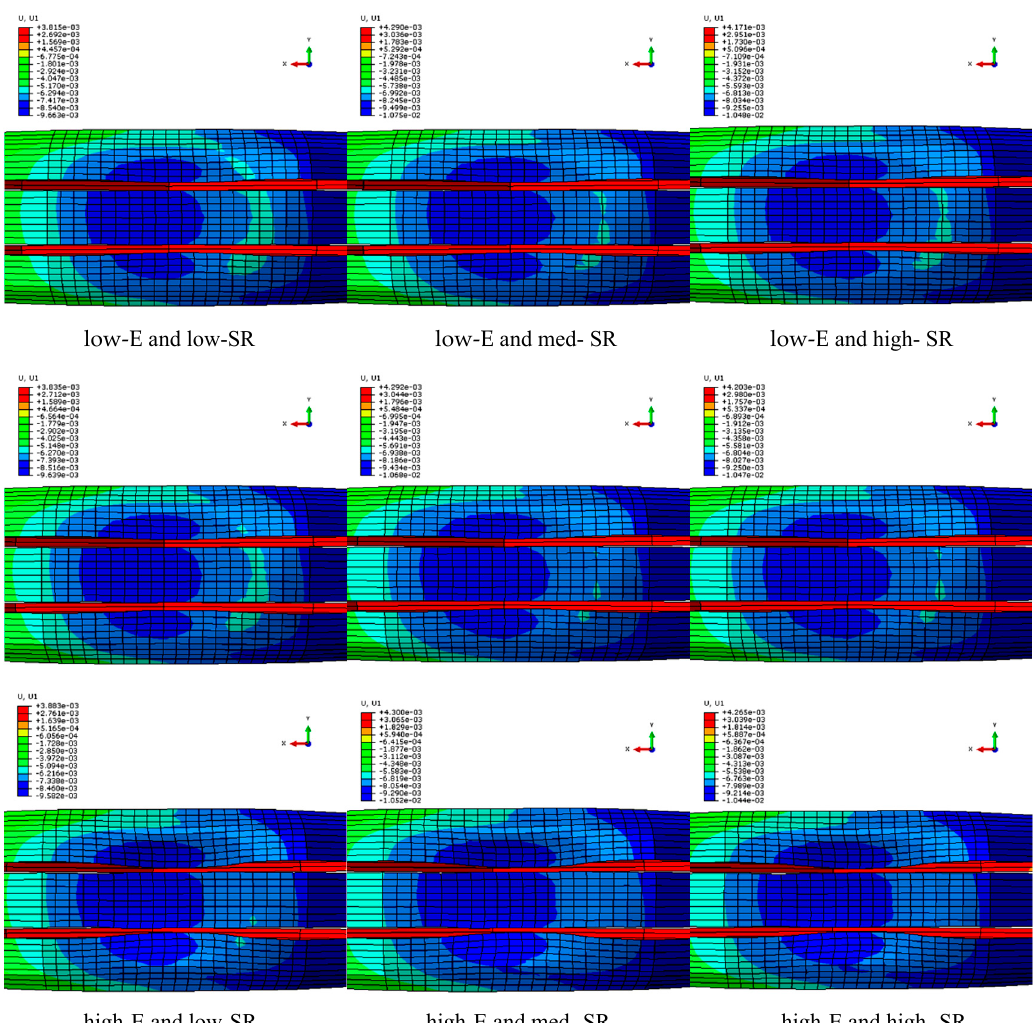
Figure 6. Tangential deformation nephogram of tire tread under different slip ratios.